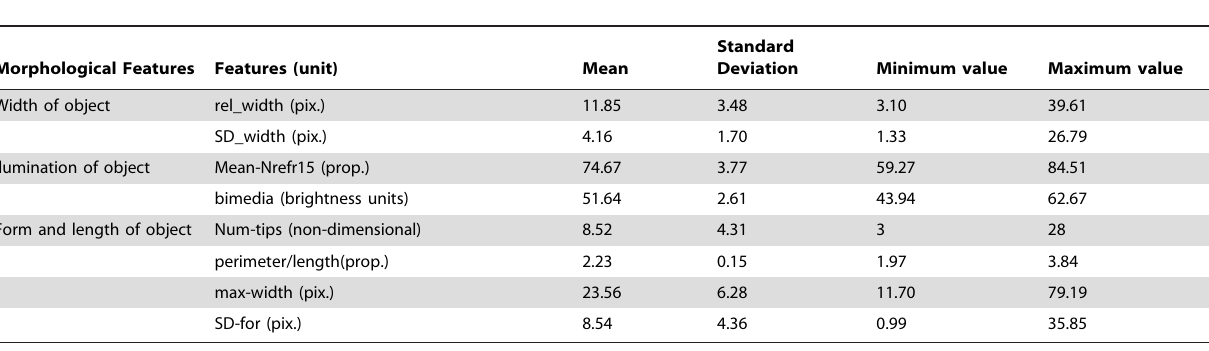
Table 2. Univariate analysis of the main features relevant to the prediction of TB positive objects.